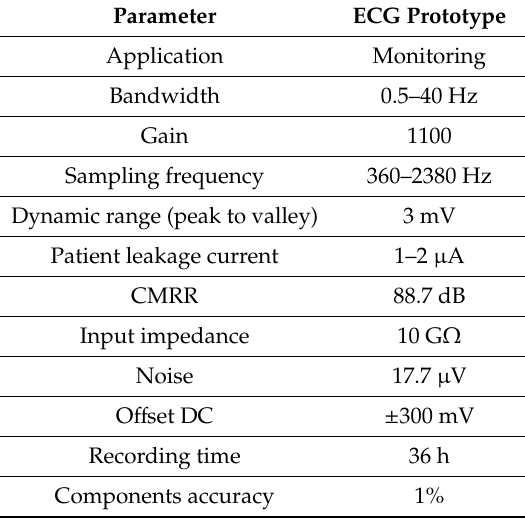
Table 8. ECG breadboard prototype